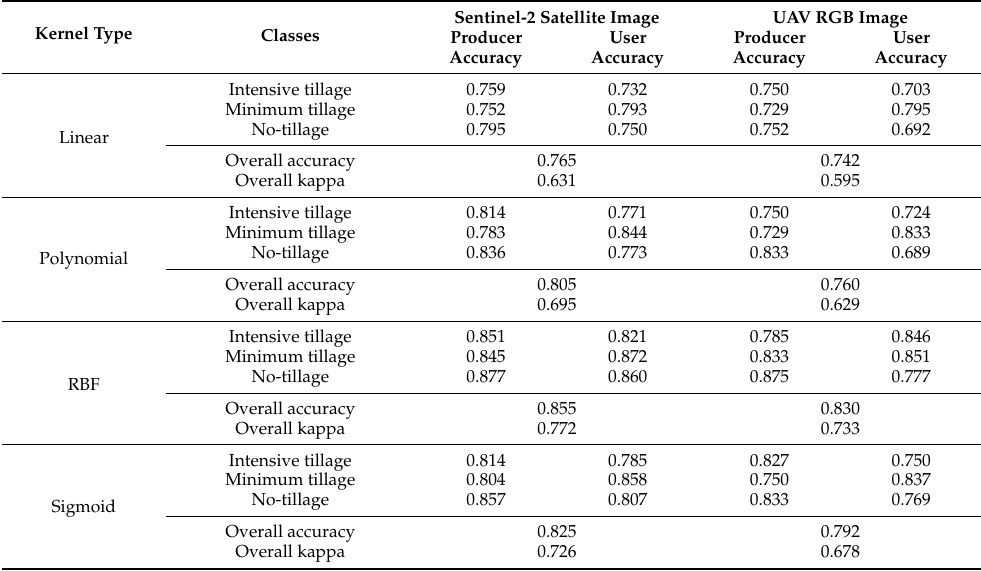
Table 7. Results of pixel-based SVM classifications algorithms with different kernels for the digital images from the UAV and spectral image from Sentinel-2 satellite.